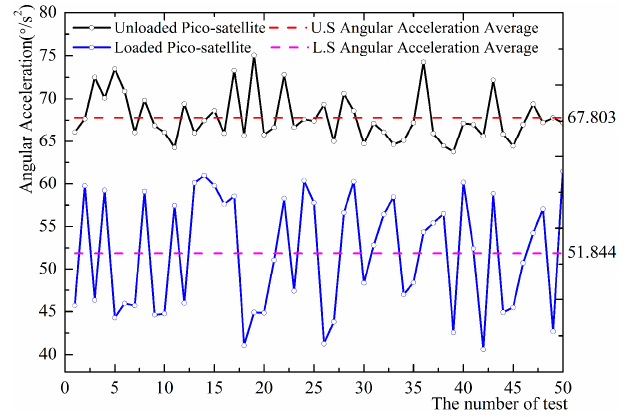
Figure 12. Angular acceleration in different states at horizontal position- α .